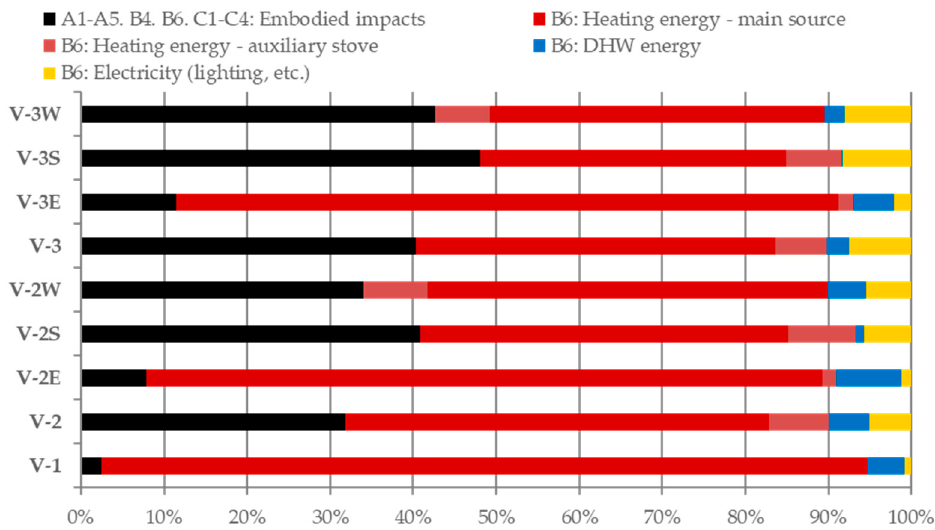
Figure 5. Shares of the particular systems on operational energy consumption and overall environ- mental impacts (OEIs) of the house variants.